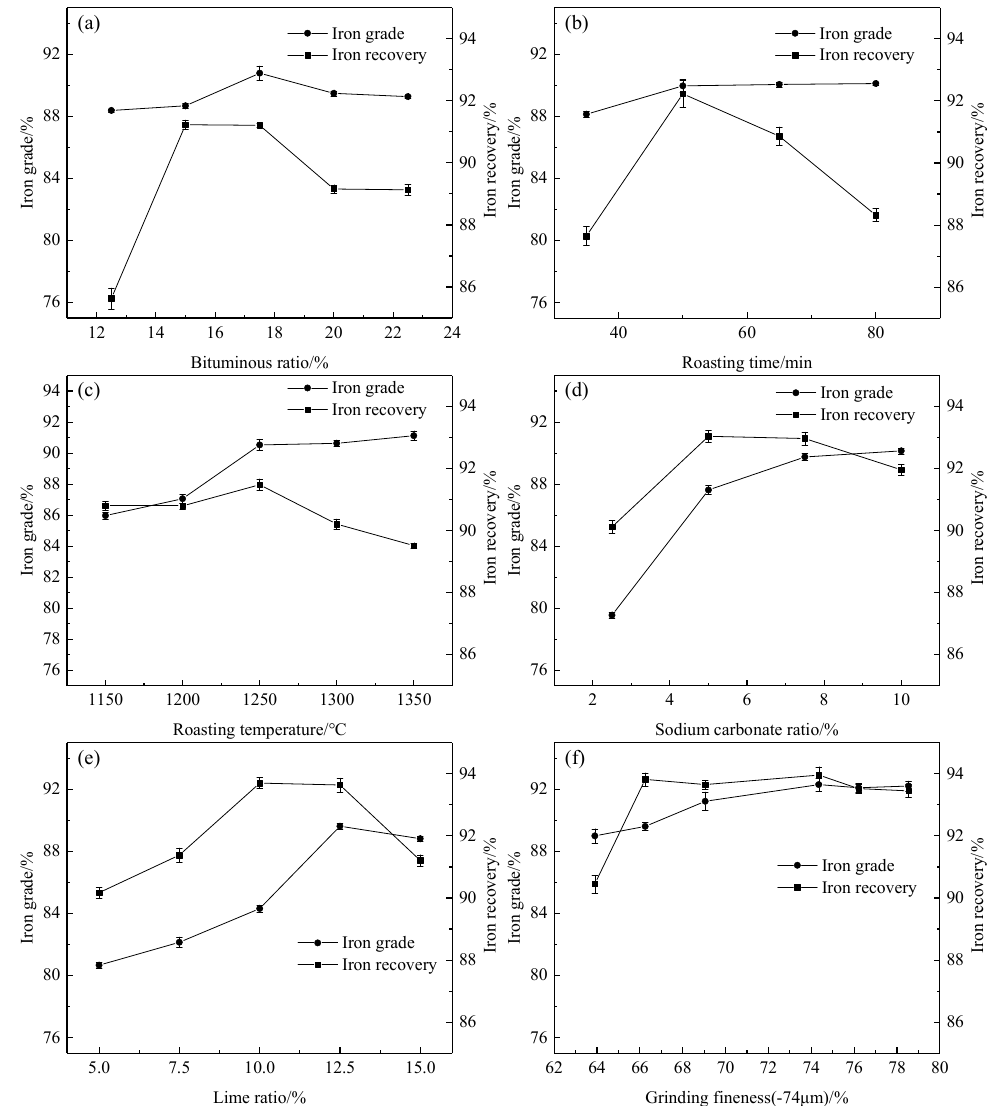
Figure 3. Effect of different influencing factors on iron recovery and iron grade: ( a ) Bituminous ratio; ( b ) roasting time; ( c ) roasting temperature; ( d ) sodium carbonate ratio; ( e ) lime ratio; ( f ) grinding fineness.